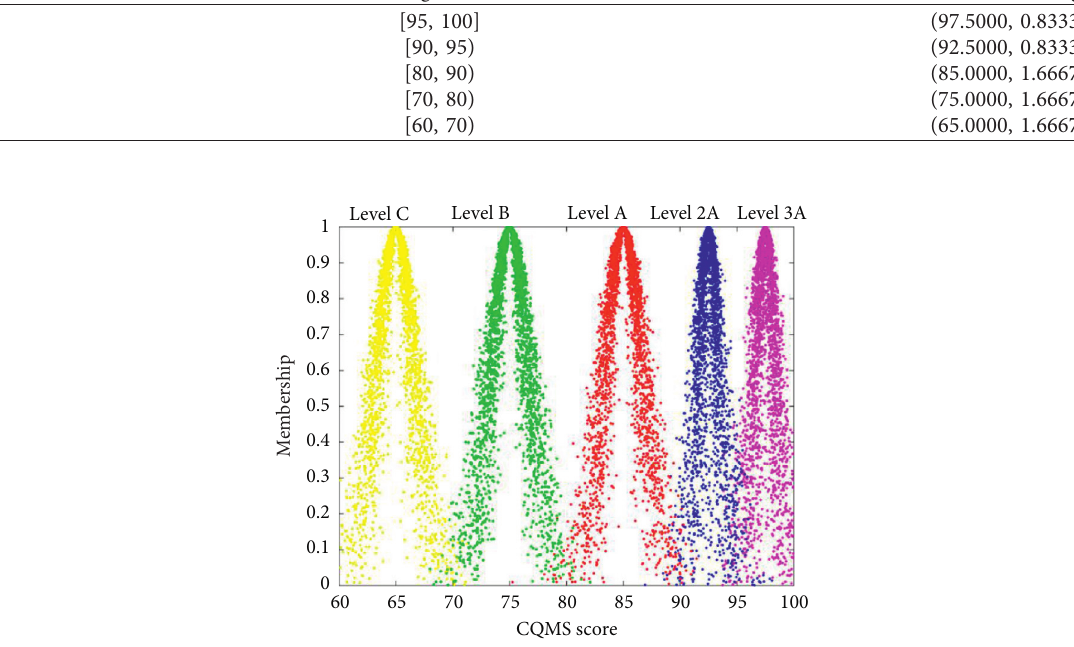
Figure 4: Standard cloud map of CQMS